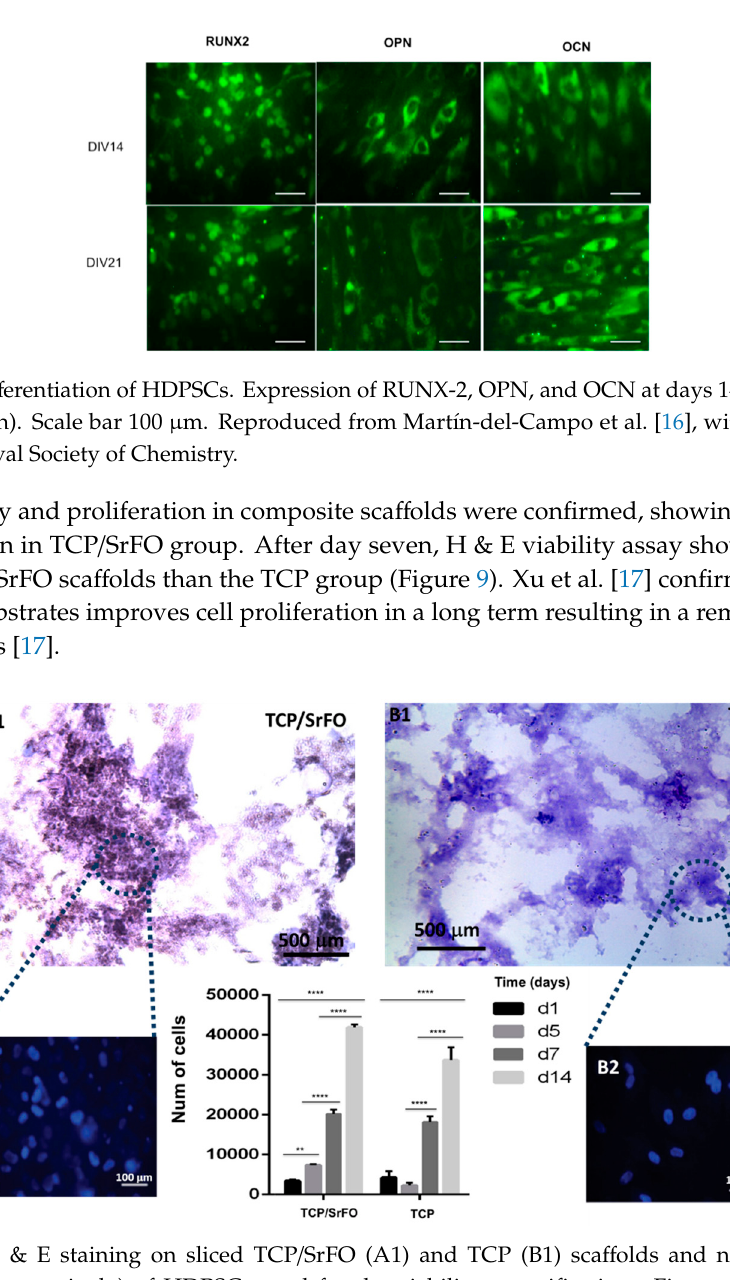
Figure 10. Implementation of the cranial defect model and construct (circle) transplantation. Process reported in Martín-del-Campo et al. [16]. The biomodels, after implantation of the constructs, showed good recovery and no signs of infection or inflammation as determined by Gross photographic examination and CT analysis. The implanted scaffolds resorb because of formation of newly mineralized tissue. Moreover, radiographic scans of ex vivo bone explant may evidence qualitatively and quantitatively the mineralized tissue in calvaria defects over time. The progressive healing (filling) of cavities is observed in both groups, which are characterized by mineralized tissue and moderate rates in bone growth. Remarkably, the density of the newly bone formed is higher in SrFO group compared with that in TCP (Figure 11) suggesting that Sr promoted the formation of new bone. Yang et al., [44] showed that in HA and Sr- containing scaffolds, the Ca phosphate based scaffold induces the formation of only some mature collagen fibers at the edges of the bone defect, while Sr-containing scaffold induces the formation of mature and remodeled bone at the boundary and in the central bone defect resulting in a relatively high bone density [44].